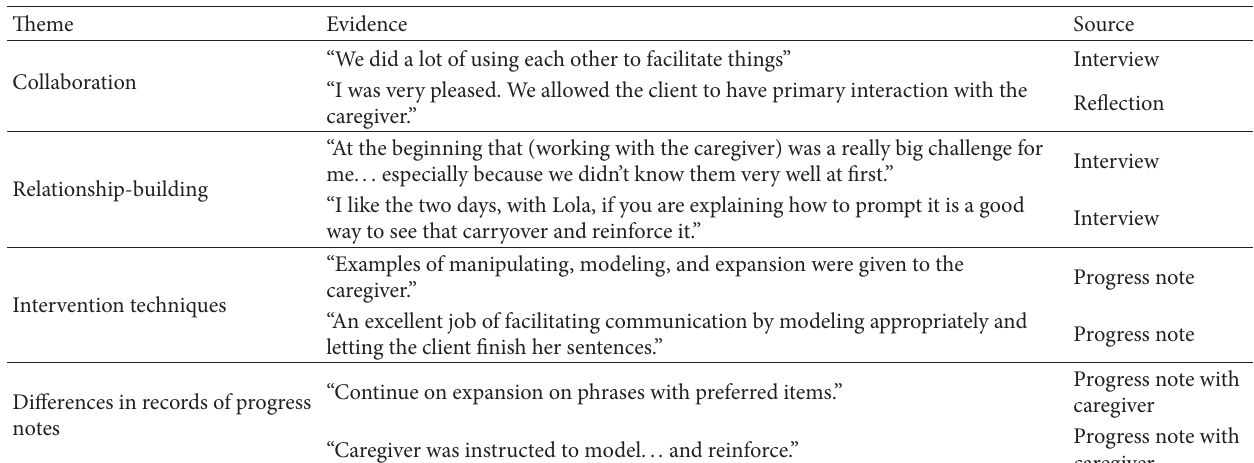
Table 4: Themes and examples of perspectives of